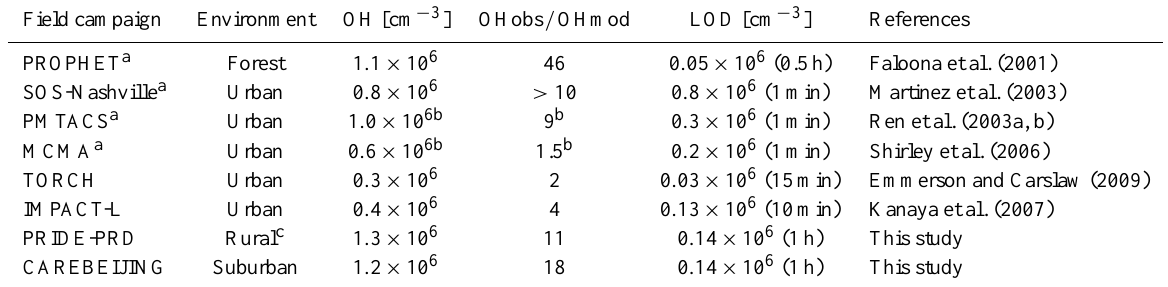
Table 3. Overview of mean nighttime OH concentrations, observed-to-modeled OH ratios (OHobs/OHmod) and limit of OH detection (LOD) from our studies and from other field campaigns where higher-than-expected nighttime OH concentrations were reported. Field